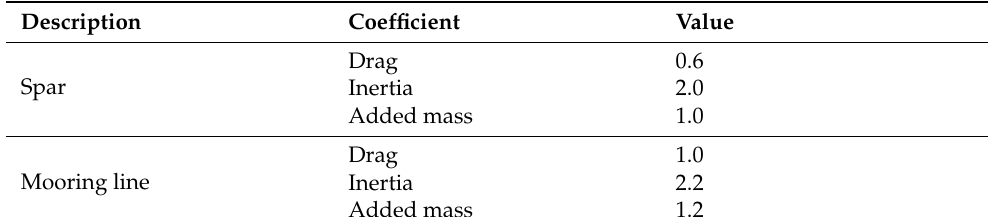
Table 2. Hydrodynamic Properties for spar platform.